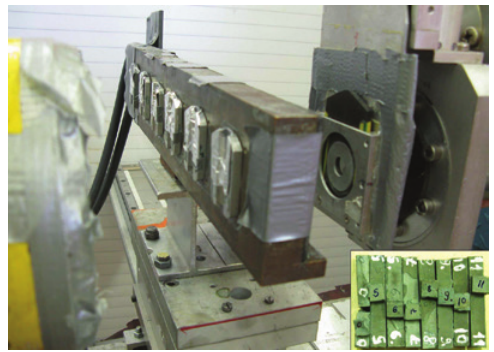
Figure 2: PCC samples in the neutron